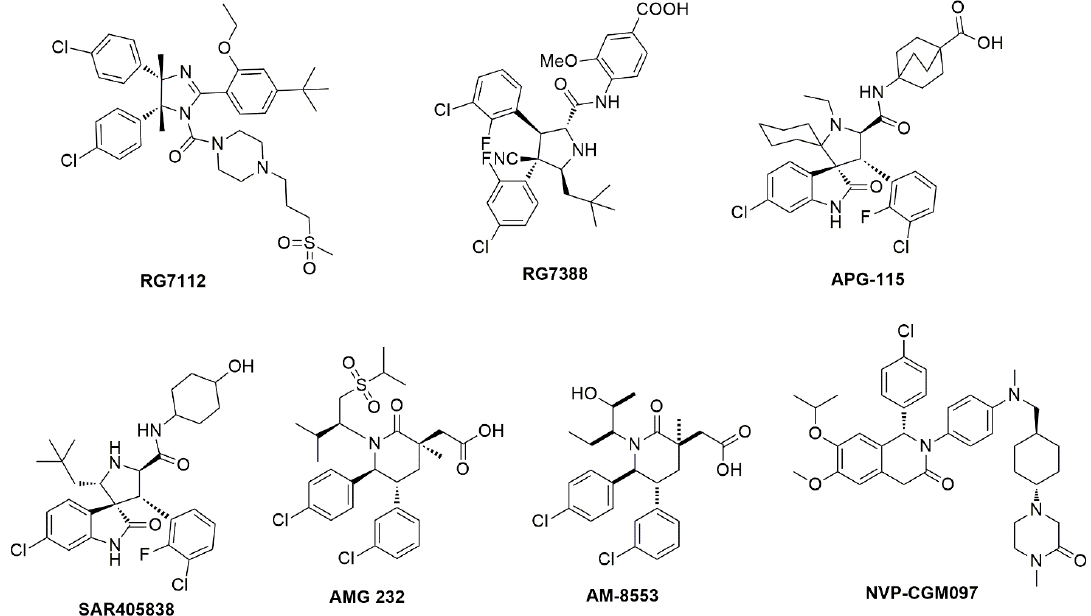
Figure 3. The MDM2/p53 inhibitors which have promoted into clinical trials.